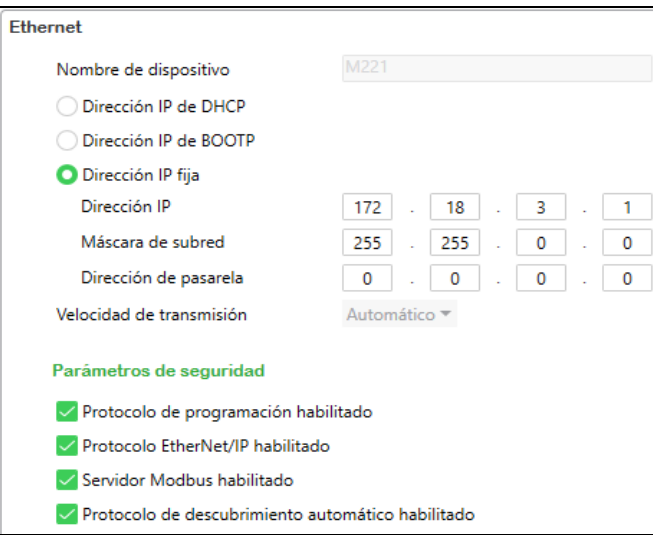
Figure 4: Configuration of the PLC's Ethernet network as Modbus TCP Server.